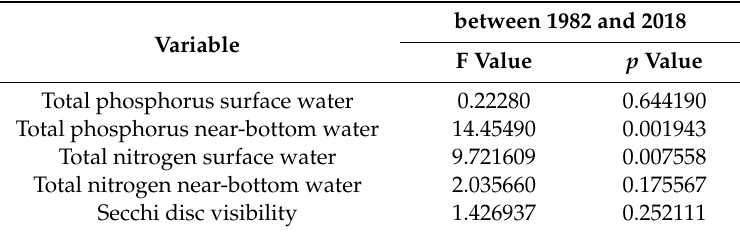
Table 3. Results of one-way ANOVA analyses (with Tukey HSD) for the investigated variables in Miłkowskie Lake water.